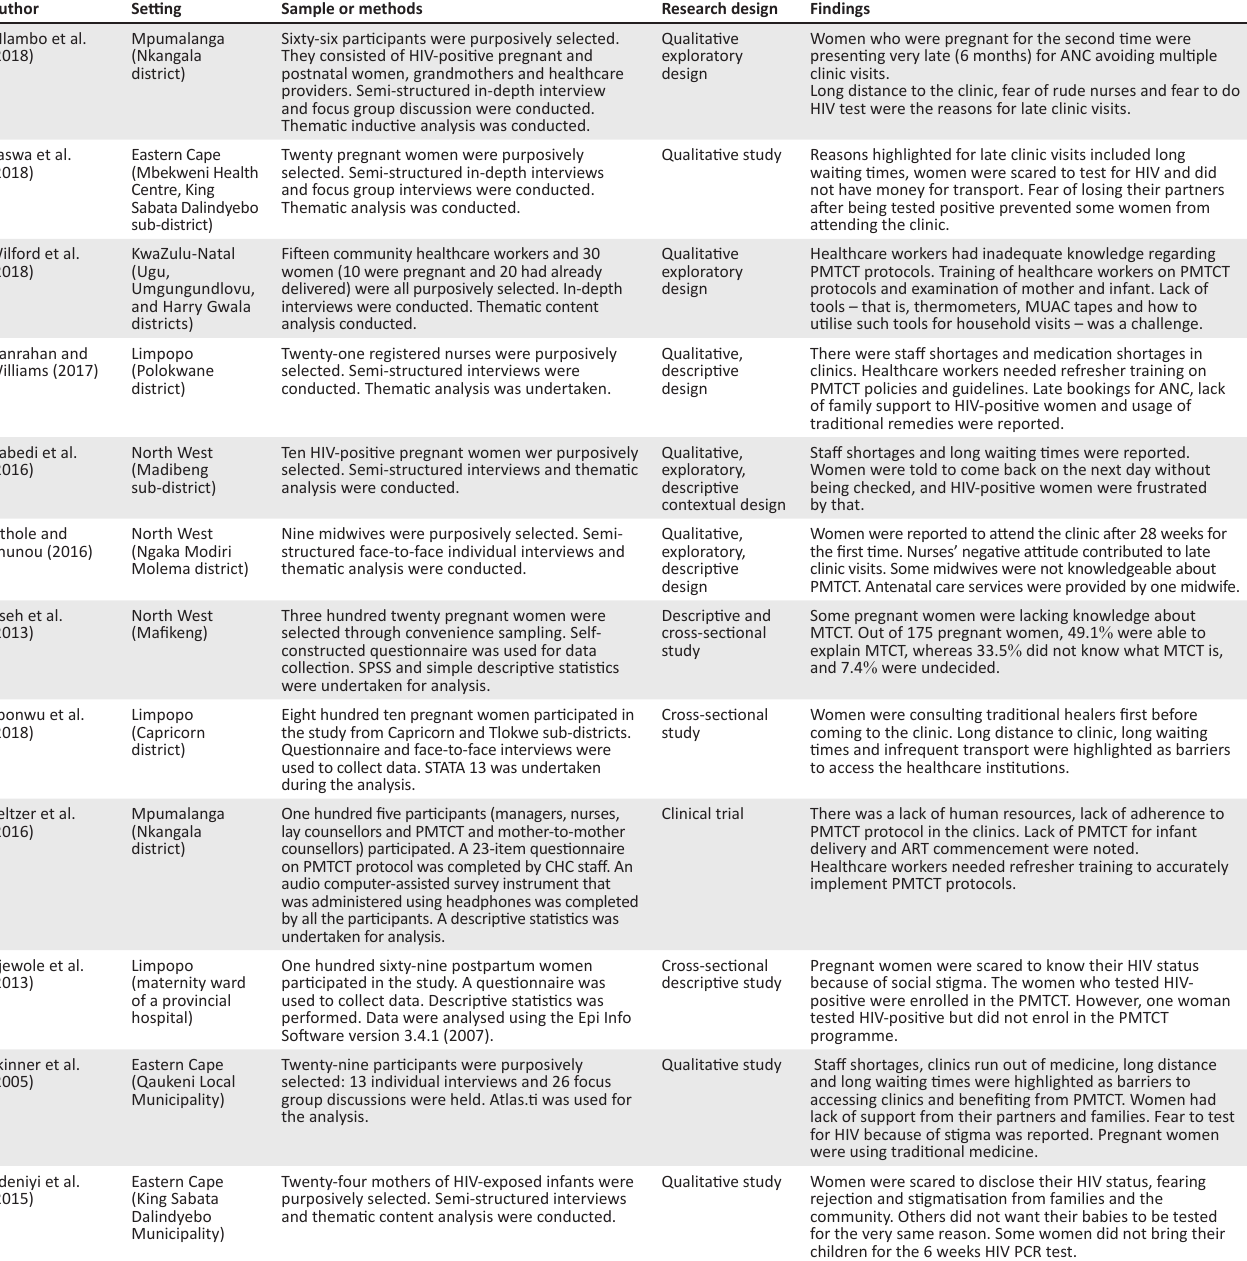
TABLE 1: Characteristics and summary of articles included in the